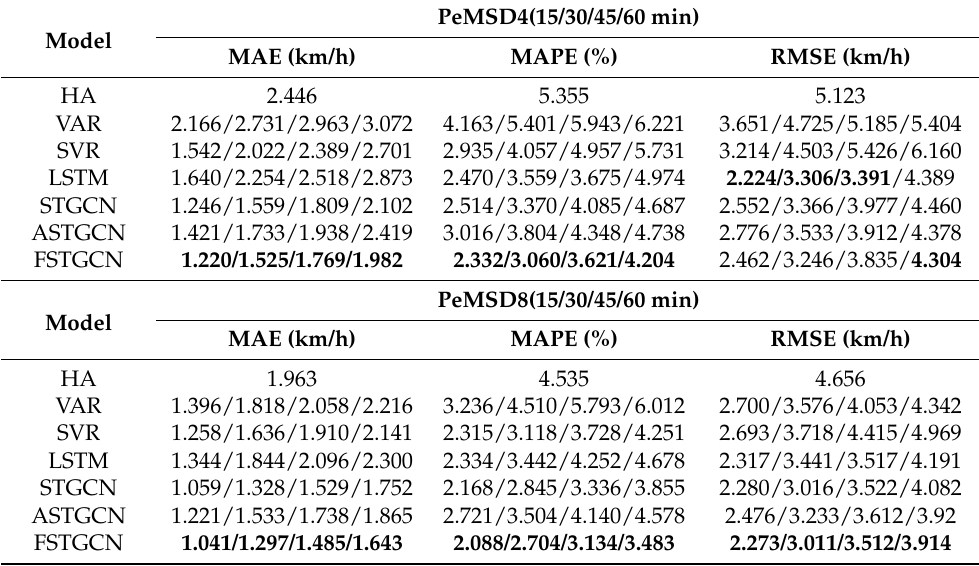
Table 2. Performance comparison of different methods on PeMSD4 and